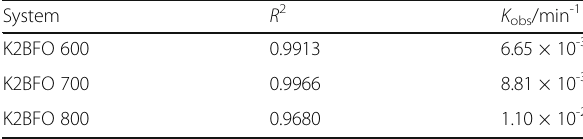
Table 4 Observed rate constant for the photodegradation of model MB dye in 15 mg of the